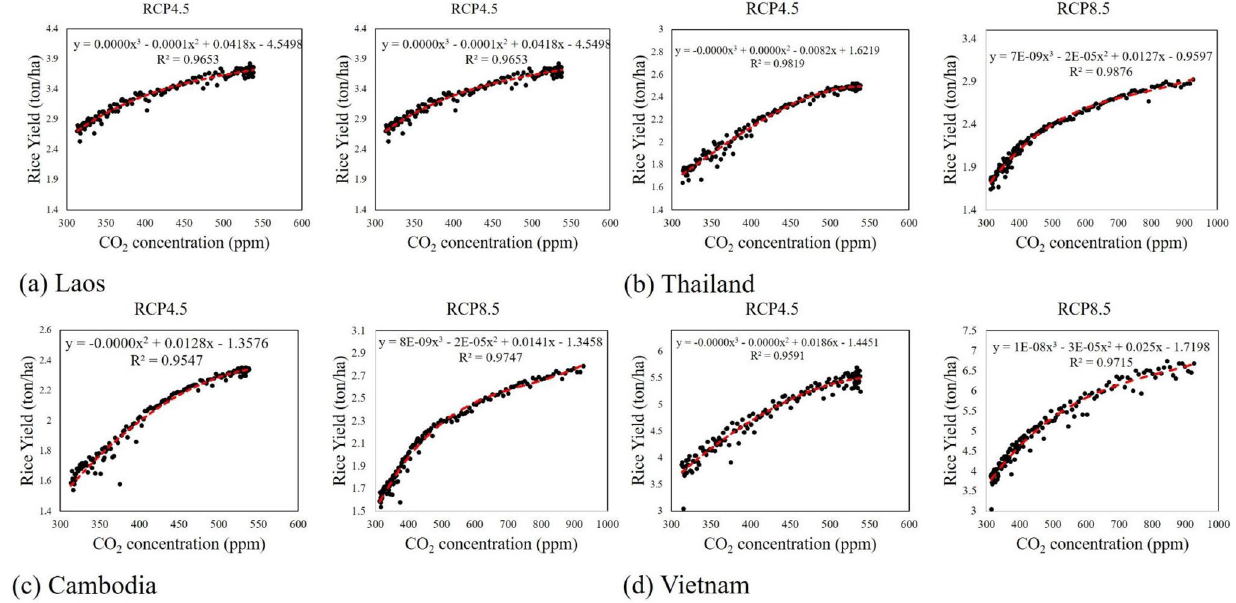
Figure 6. Non-linear plots of the CO 2 concentration (X-axis) and rice yields (Y-axis) for ( a ) Lao PDR, ( b ) Thailand, ( c ) Cambodia, and ( d ) Vietnam. For each panel, the equations on the top show the polynomial relationships, and red and dashed lines are the fitted